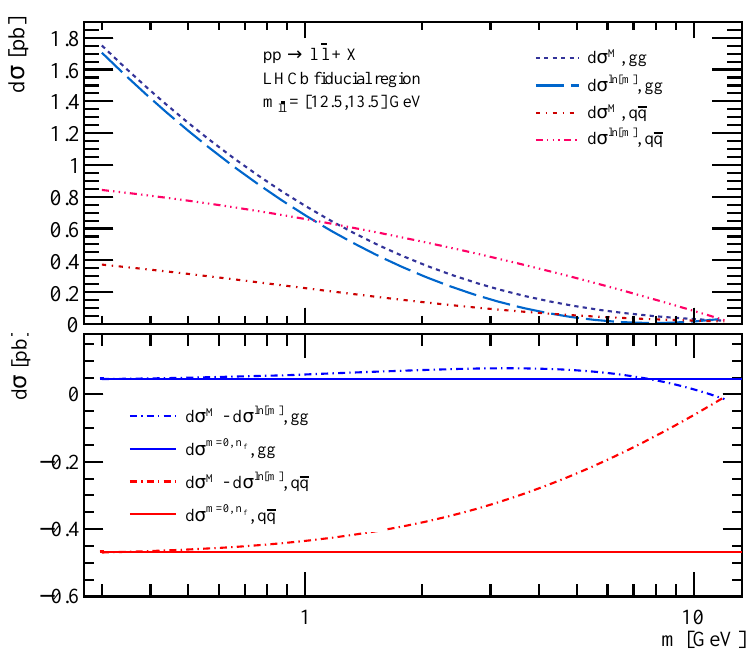
Figure 1: Upper panel: absolute cross-section for the full massive and logarithmic cal- ) . Lower panel: the cross-section difference (massive-logarithmic) culations at O ( α 2 s as compared to the direct computation of the massless n A breakdown into partonic channels is